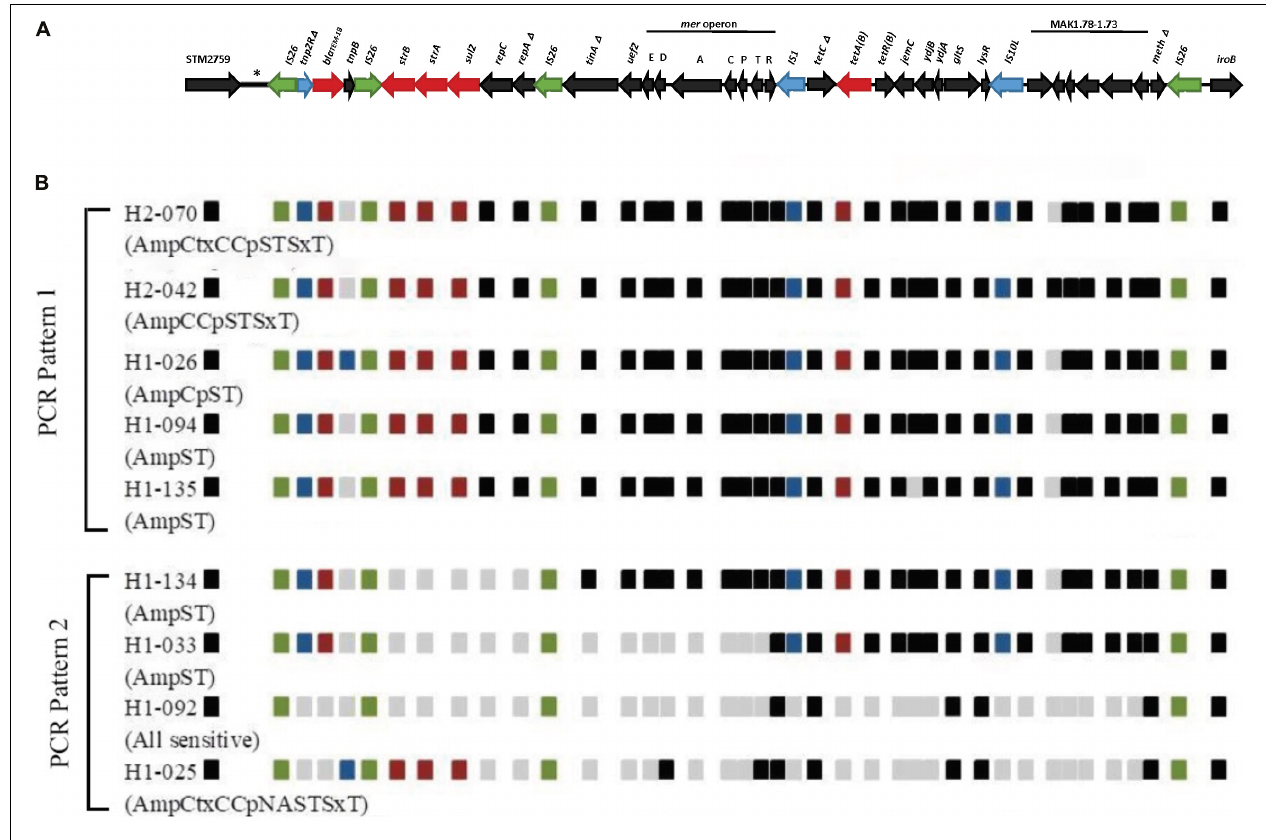
FIGURE 1 | Schematic diagram showing structures and arrangement of relevant antimicrobial resistance genes located between STM2759 and iroB gene in selected Thai S .4,5,12:i:- isolates. (A) Genetic mapping showing resistant region 3 (RR3) between STM2759 and iroB gene in the European S .4,5,12:i:- reference strain 07-2006 (GenBank: accession number KR856283) based on García et al. (2016), (B) Comparison of AMR genes structures and locations within specific region in selected Thai S .4,5,12:i:- isolates. Green boxes represent insertion sequence (IS 26 ) and blue boxes represent mobile elements other than IS 26 . Resistance genes are indicated by red-colored boxes. Black boxes indicate the presence of genes other than AMR genes while gray boxes show the absence of the genes in these locations that are found in reference strain. Nine isolates are selected here as an example of PCR patterns 1 and 2. Amc, Amoxicillin/Clavulanic acid; Amp, Ampicillin; Ctx, Cefotaxime; C, Chloramphenicol; Cp, Ciprofloxacin; NA, Nalidixic acid; Nor, Norfloxacin; S, Streptomycin; T, Tetracycline; SxT,